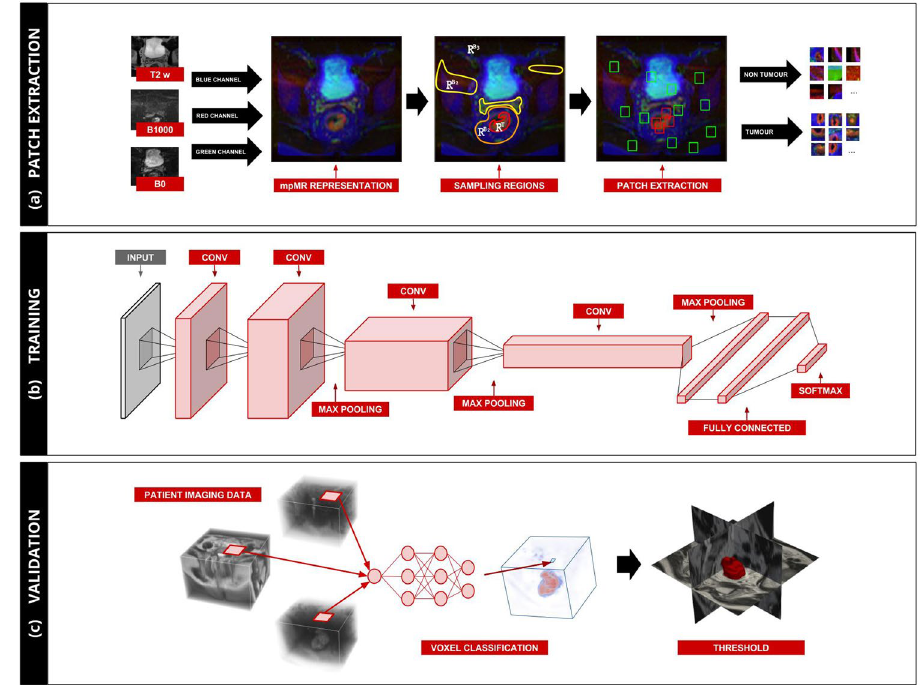
Figure 2. Scheme of the Proposed Solution. ( a ) On the left-hand side, a multiparametric representation of the imaging is created via fusion of corresponding slices from different sequences into the colour channels of the RGB model. In the centre, the label map is first divided in tumour region (R T ) and the background regions (R B ) according to the delineation done by the experienced reader. On the right-hand side, N voxels (together with their surrounding patch) are then randomly sampled from these regions to maintain a balance between number of voxels representing the tumour and number of voxels representing healthy tissue. ( b ) The architecture of the network, which is trained with the patches of the images in the discovery set. The patches of the images in the test set are used to control for model overfitting. ( c ) The 3D probability map is generated by classification of each voxel using the trained model. The probability map is thresholded to find the components where the probability of tumour is higher than the probability of healthy tissue. The largest component is selected as segmentation of the